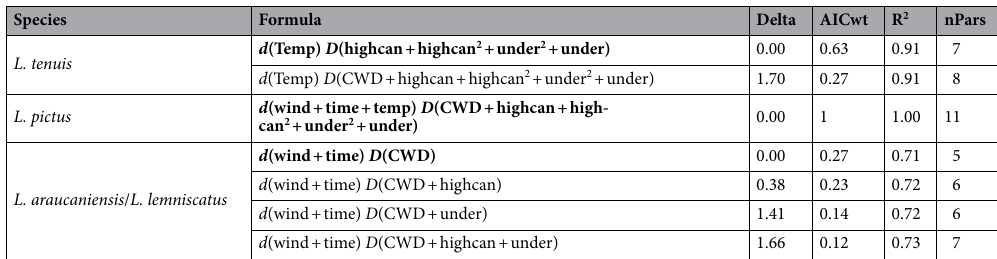
Table 1. Statistics for best-ranked models (ΔAIC < 2) of lizard species in Araucaria forests of La Araucanía Region, Chile. We show models formulas indicating detection covariates ( d ) and density covariates ( D ). Best model is highlighted in bold for each